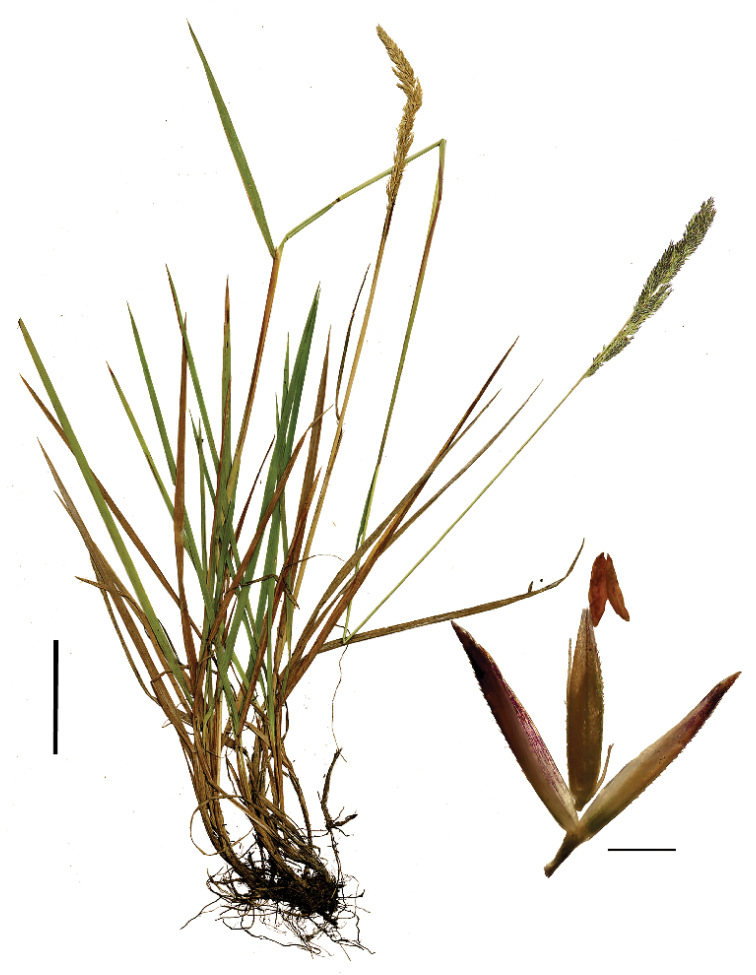
Calamagrostiscf.carchiensis Lægaard general habit (scale bar 5 cm) and spikelet. Scale bar: 1 mm; S.P. Sylvester 3049 (FMB).